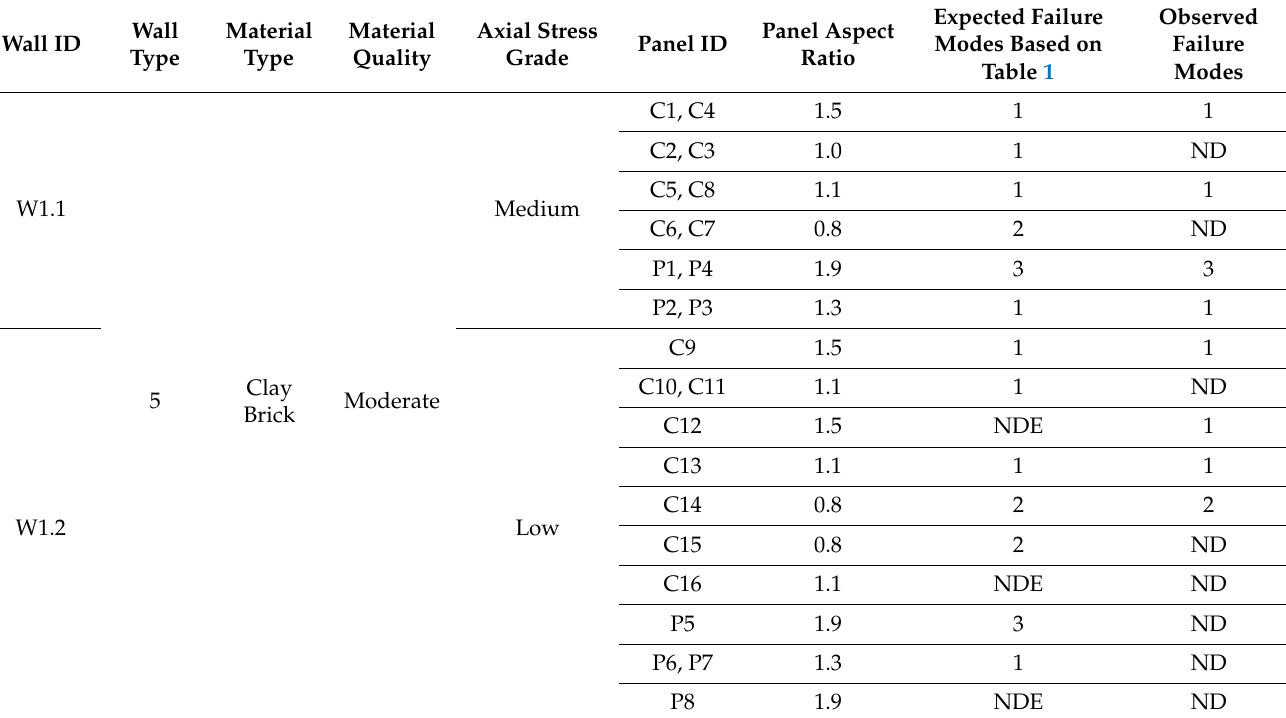
Table 2. Comparison of expected and actual failure modes of the URM wall.